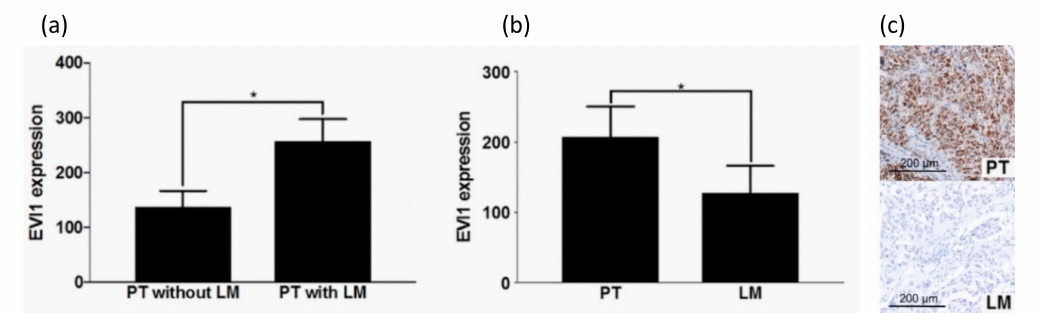
Figure 4. Correlation of EVI1 expression in LN + and LN- primary HNSCC and EVI1 expression in the primary tumor and the related cervical lymph node metastasis. Primary tumors (PT) were grouped by their cervical lymph nodal status. EVI1 expression in PTs that had at least one cervical lymph node metastasis (LM) was significantly higher than in those PTs that had not formed LMs yet ( a ) (*unpaired t -test, statistically significant (* p < 0.05)). EVI1 expression of PTs, which had at least one LM, already was determined. EVI1 expression of each of these tumors was compared with EVI1 expression of the matched LM. EVI1 expression in PTs was significantly higher than in the matched LMs ( b ) (paired t -test, statistically significant (* p < 0.05)). Photomicrographs of EV11 expression of matched PT and LM are shown in ( c ). Scale bar represents 200 µ m.